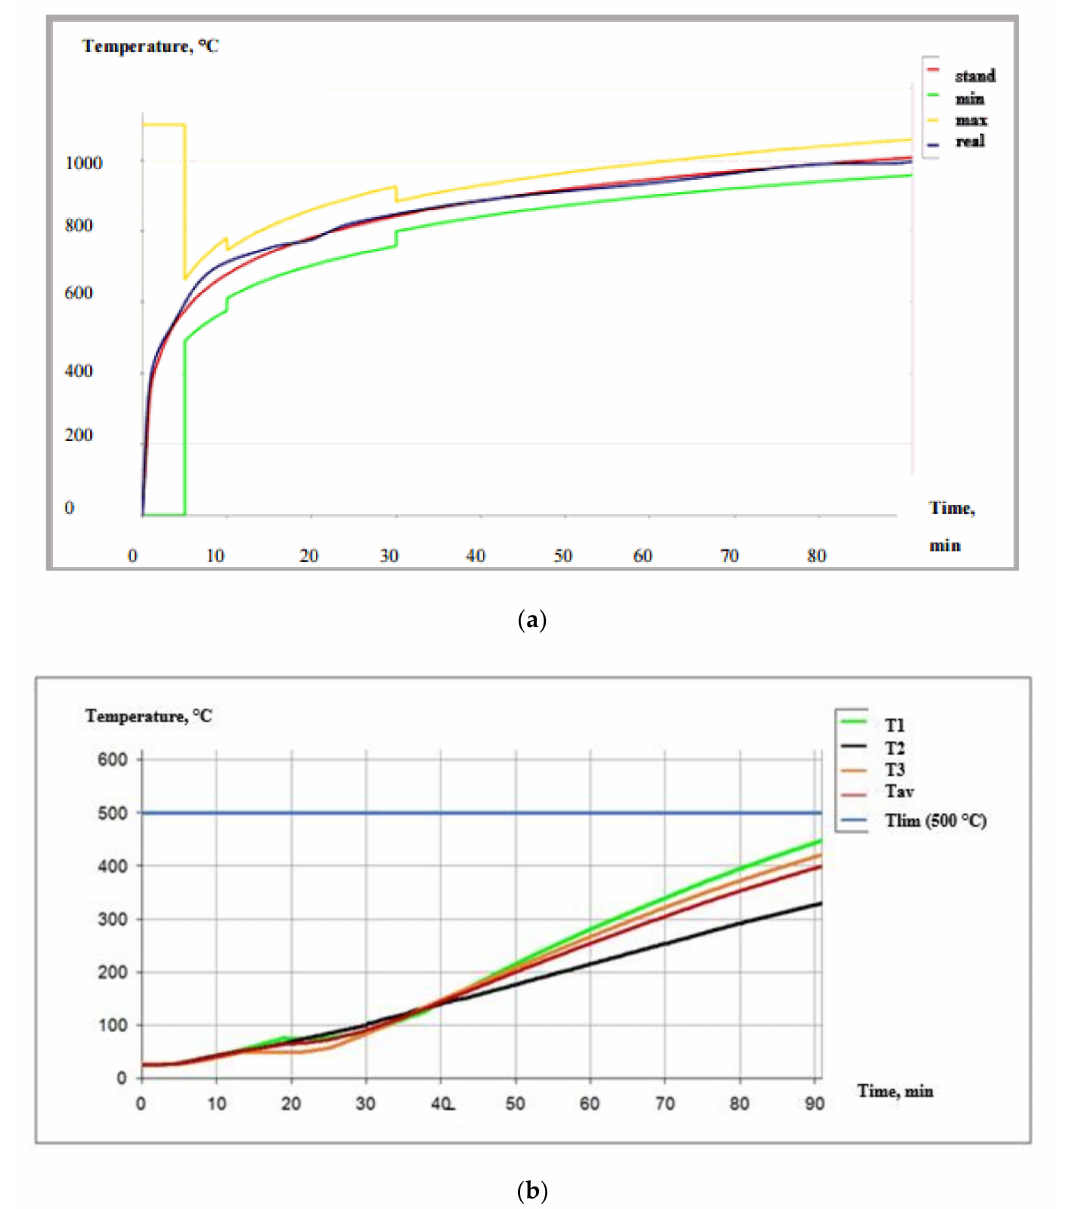
Figure 9. ( a ) The temperature regime of the tests GOST 30247.1-94 [24]. ( b ) Structure heating during the test according to GOST 30247.1-94